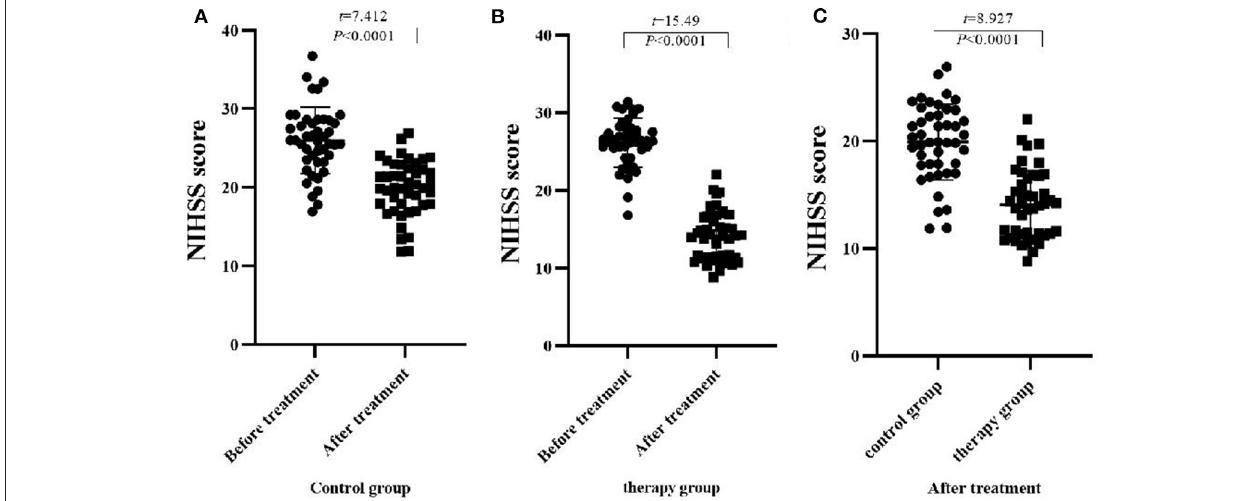
FIGURE 1 | Comparison of NIHSS scores before and after treatment between the two groups (M ± S D, scores). (A) Comparison of NIHSS scores of the control group before and after treatment; (B) Comparison of NIHSS scores of the therapy group before and after treatment; (C) Comparison of NIHSS scores of the two groups after treatment.